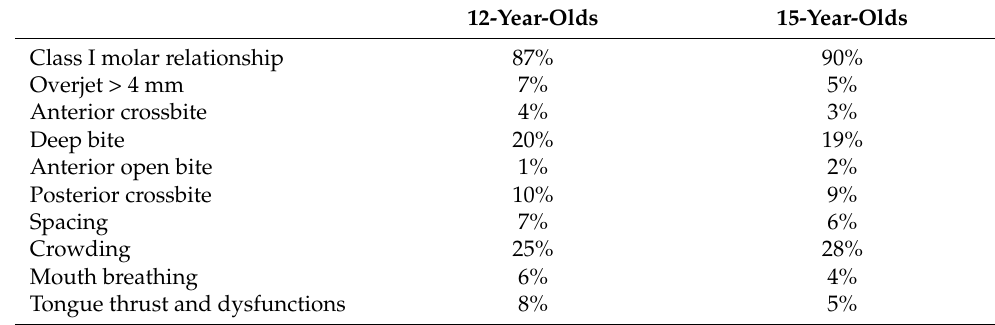
Table 6. Orthodontic